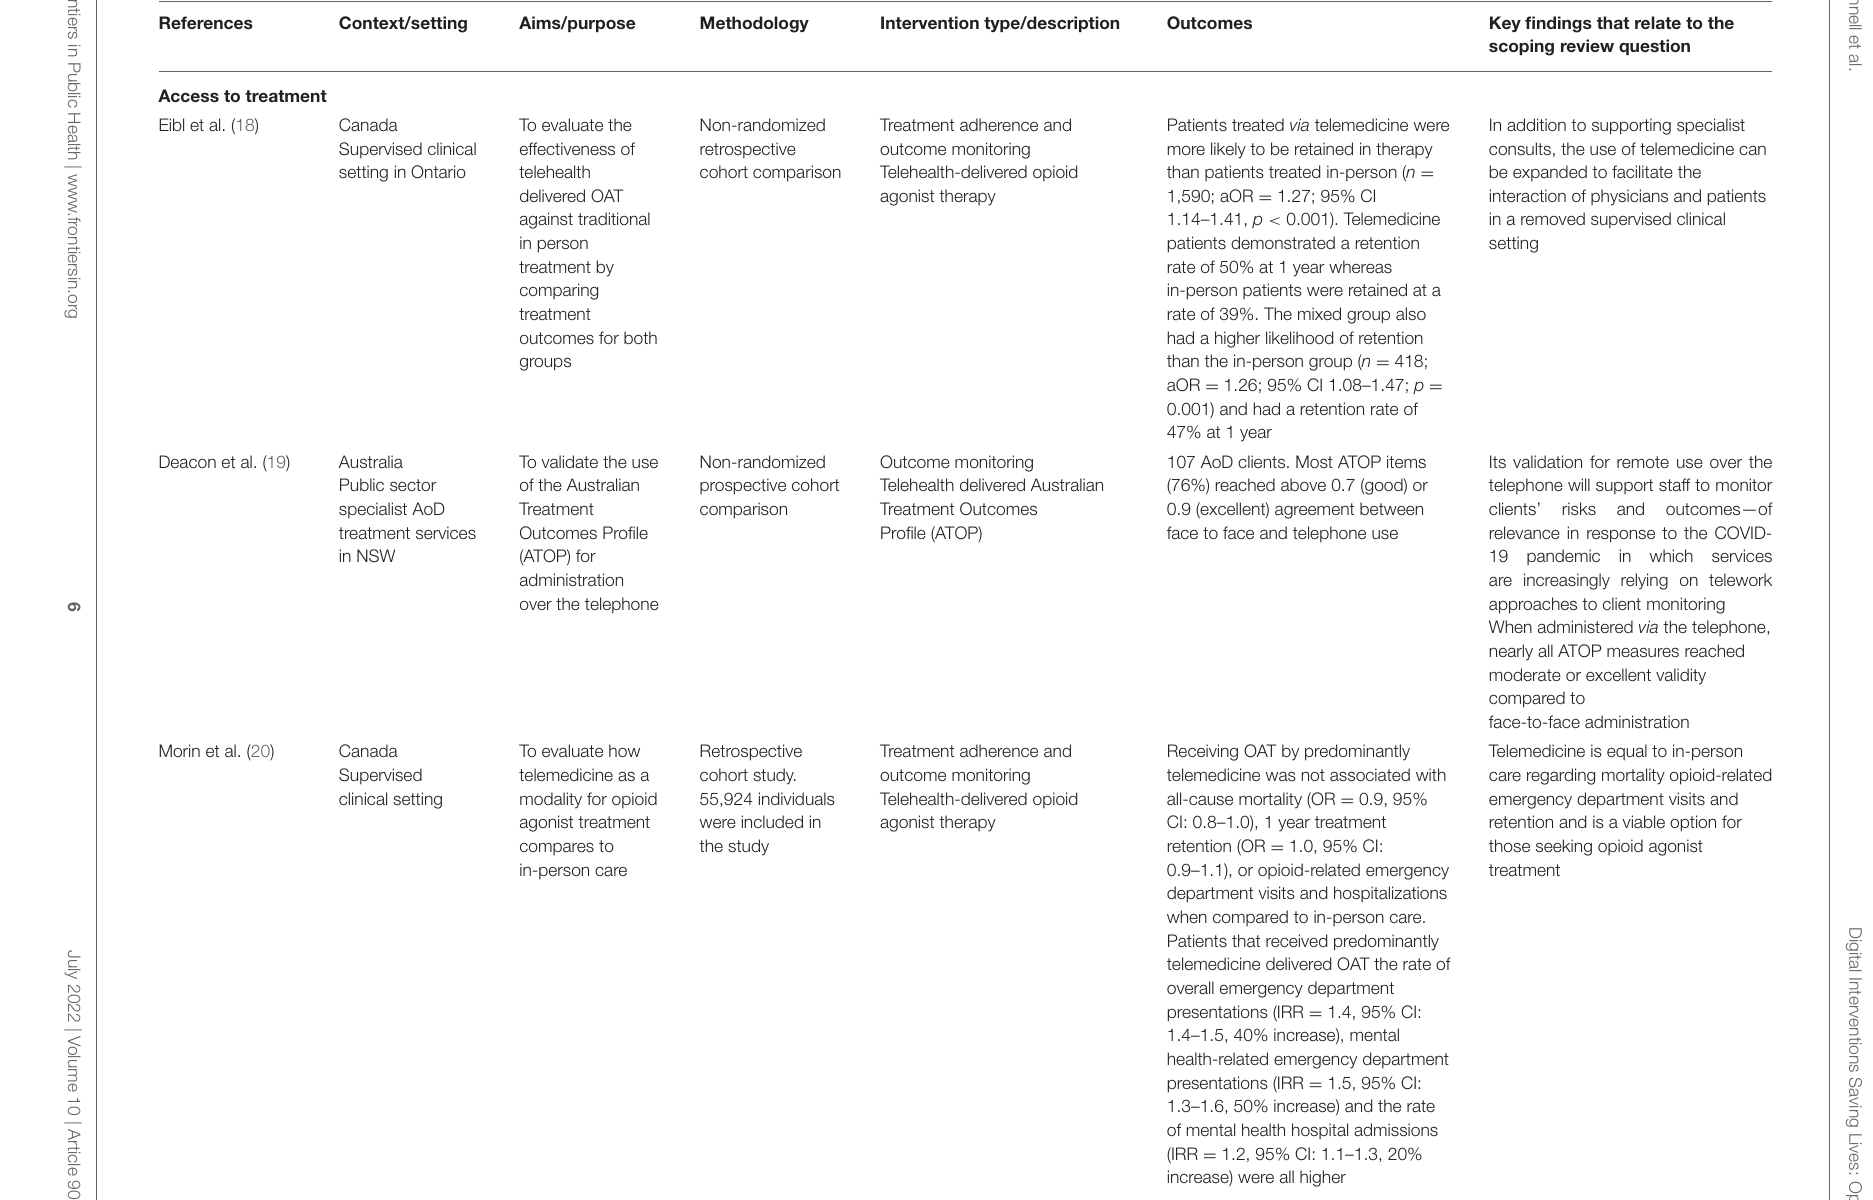
TABLE 1 | Characteristics of included